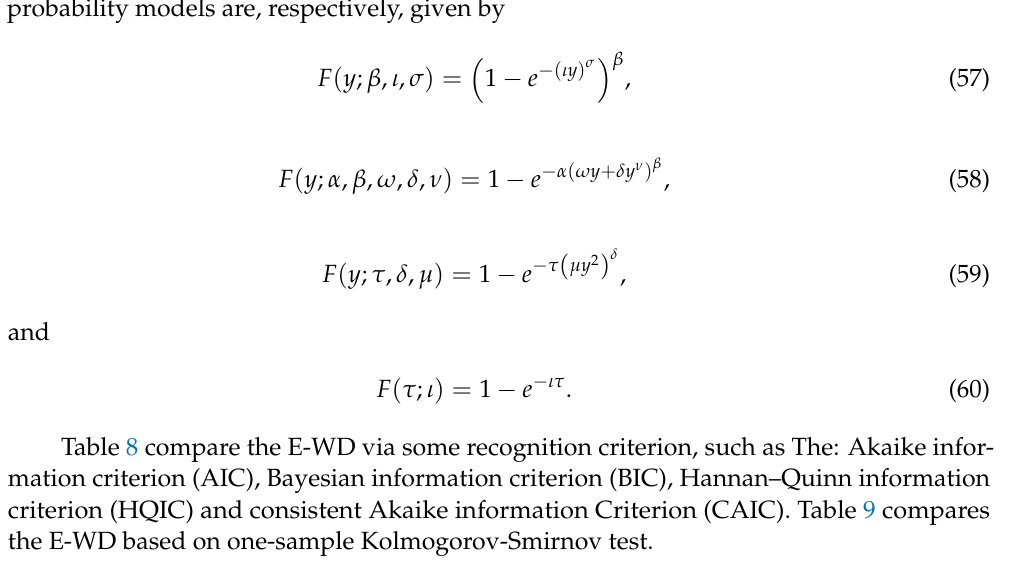
Table 8. Relative quality of the E-WD vs. competing models. Model AIC CAIC BIC HQIC E-WD